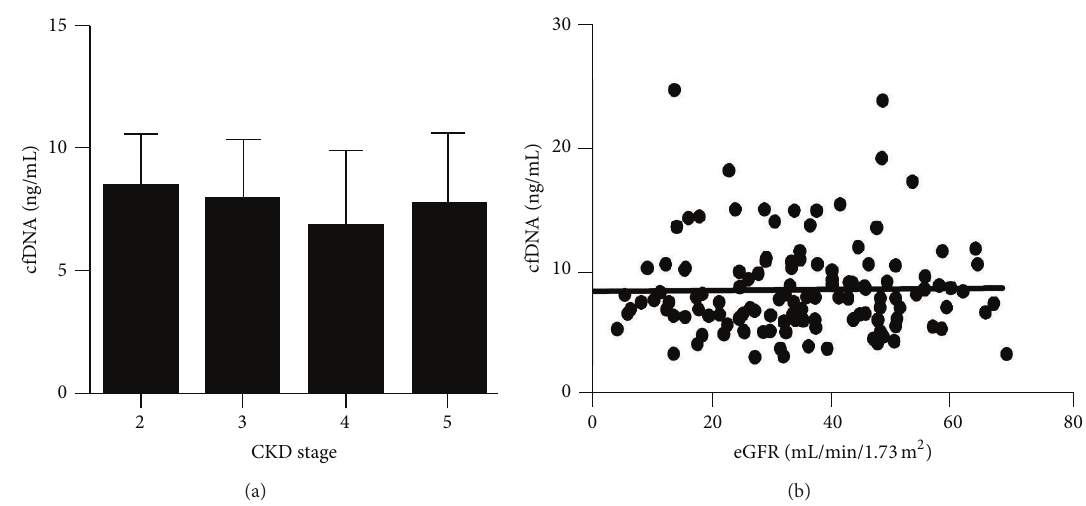
Figure1:Cell-freeDNAlevelsinpatientswithrenalimpairment.(a)ComparisonofcfDNAlevelsbyCKDstage(meanandSDareshown).No difference in any group was evident ( 𝑃 = 0.49 ). (b) Correlation between estimated glomerular filtration rate (calculated using the 4-variable MDRD equation) and cfDNA levels for individual patients is shown ( 𝑟 2 = 0.0002 , 𝑃 = 0.87 ).